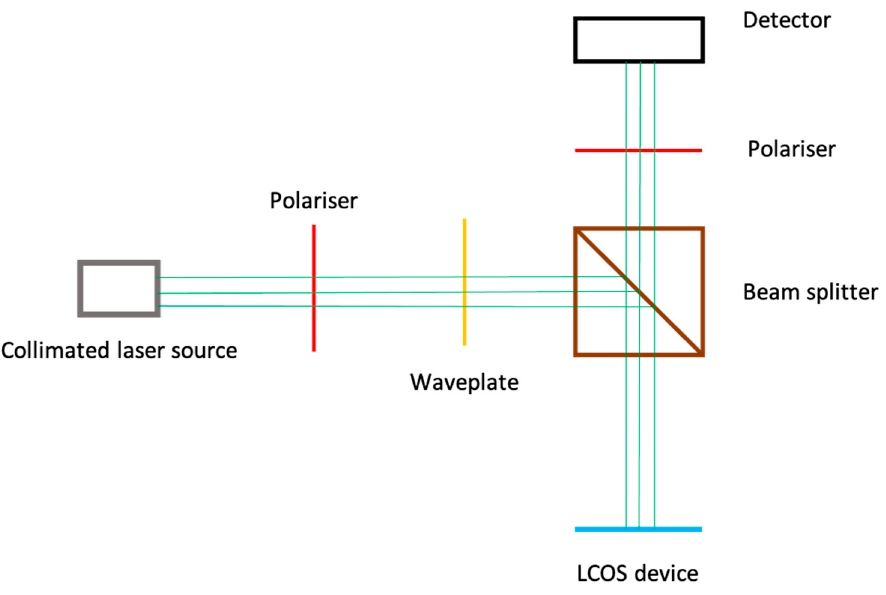
Figure 9. New experimental setup with an additional waveplate.